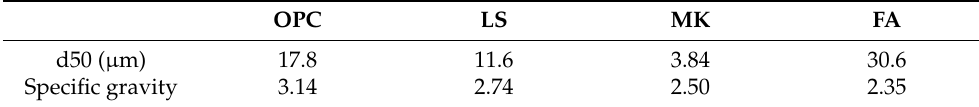
Figure 1. Particle size distributions of binders. Table 2. Physical properties of materials.